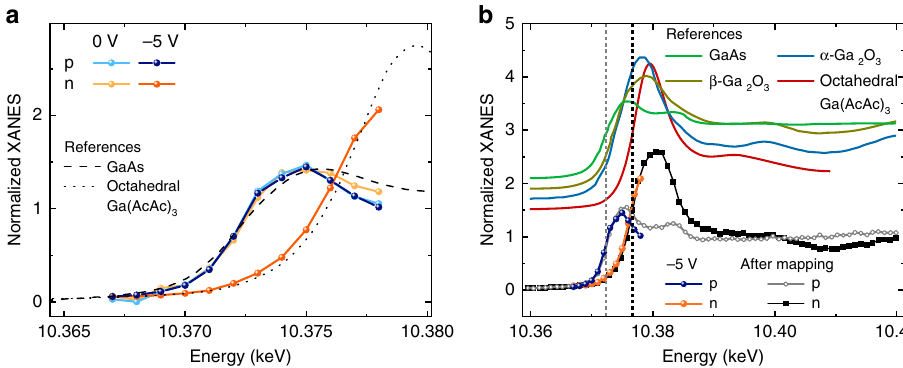
Fig. 4 Ga K-edge XANES in the p and n-type segment. a Edge region of the X-ray absorption near-edge spectroscopy (XANES) spectra measured around the Ga K-edge at the p-doped (blue) and the n-doped (orange) part of the GaAs nanowire at 0 V (light colors) and − 5 V (dark colors), respectively. References for GaAs and Ga in octahedral coordination (Ga(AcAc) 3 are added as dashed and dotted lines 31,32 . A clear shift in the absorption edge can be observed in the n-doped region for the measurement at − 5 V. b Ga K-edge XANES spectra measured after all high-resolution XBIC/XRF maps in the p and the n-type segment (black hollow circles and squares) displayed together with the edge region spectra for − 5 V and reference data 31,32 . The dashed, vertical lines indicate the Ga K-edge energies from the p- and n-type segment,